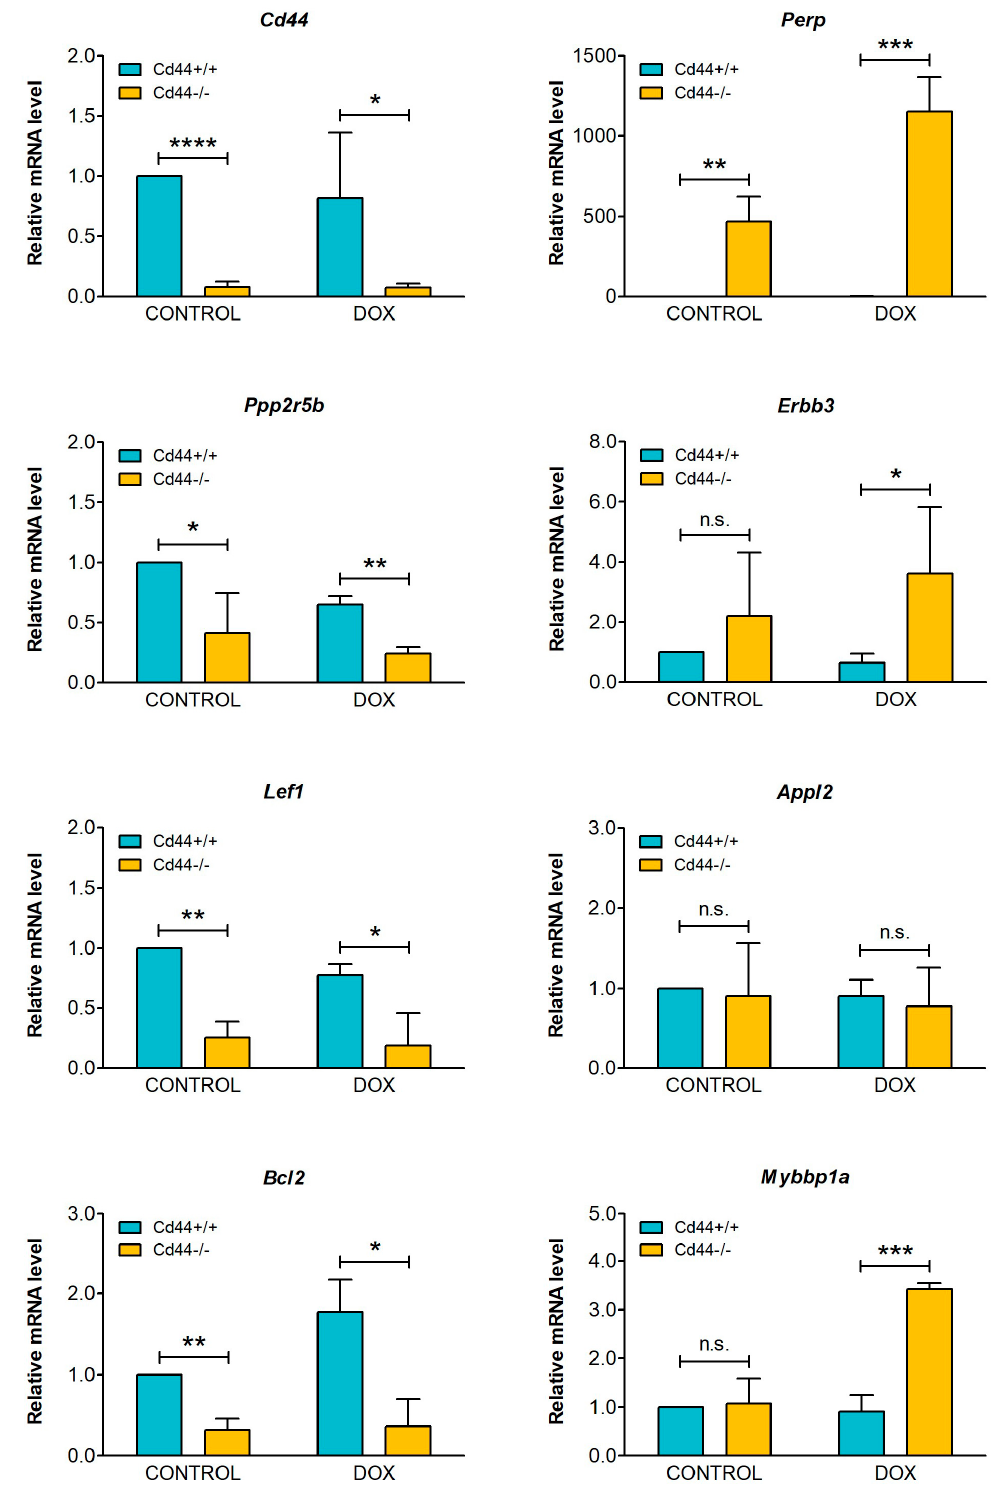
Figure 6. Testing mRNA levels of selected apoptosis-associated genes. Cd44 -positive wild-type cells, Cd44 -negative cells, and cells with reconstituted expression of Cd44s and Cd44ICD were seeded at 60% confluency in DMEM medium supplemented with 7% FBS. The cells were incubated for 24 h with pure solvent (controls) or 1.5 µM DOX. The histograms show mean values of mRNA levels ±SD from three independent experiments. Student’s t -test values: n.s.: p > 0.05, *: p ≤ 0.05, **: p ≤ 0.01, ***: p ≤ 0.001, ****: p ≤ 0.0001.